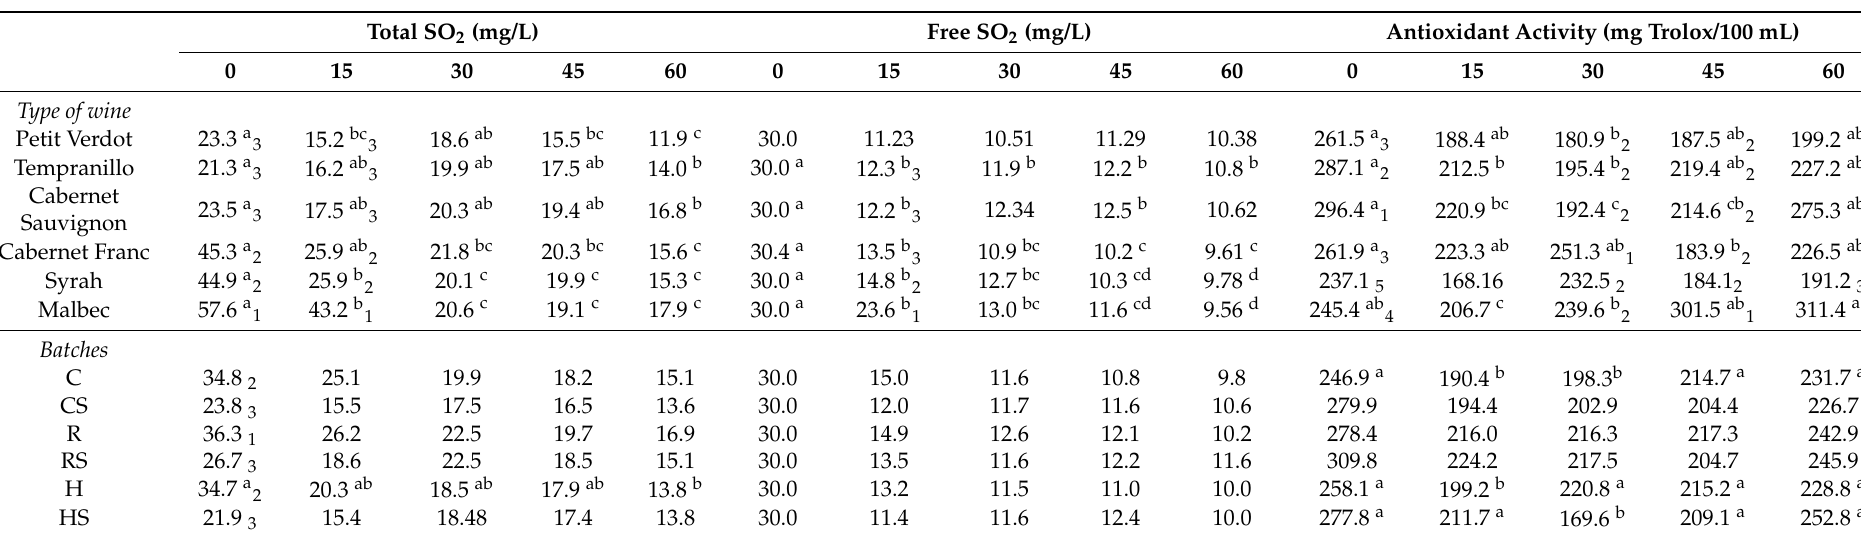
Table 6. Evolution of SO 2 total and free content (mg/L) and of antioxidant activity (mg Trolox/100 mL) during wine storage. (C: control batch, CS: control batch with sulfur dioxide; R: batch of scratch, RS: batch of scratch plus sulfur dioxide, H: batch of skin and HS: batch of skin plus sulfur dioxide). Total SO 2